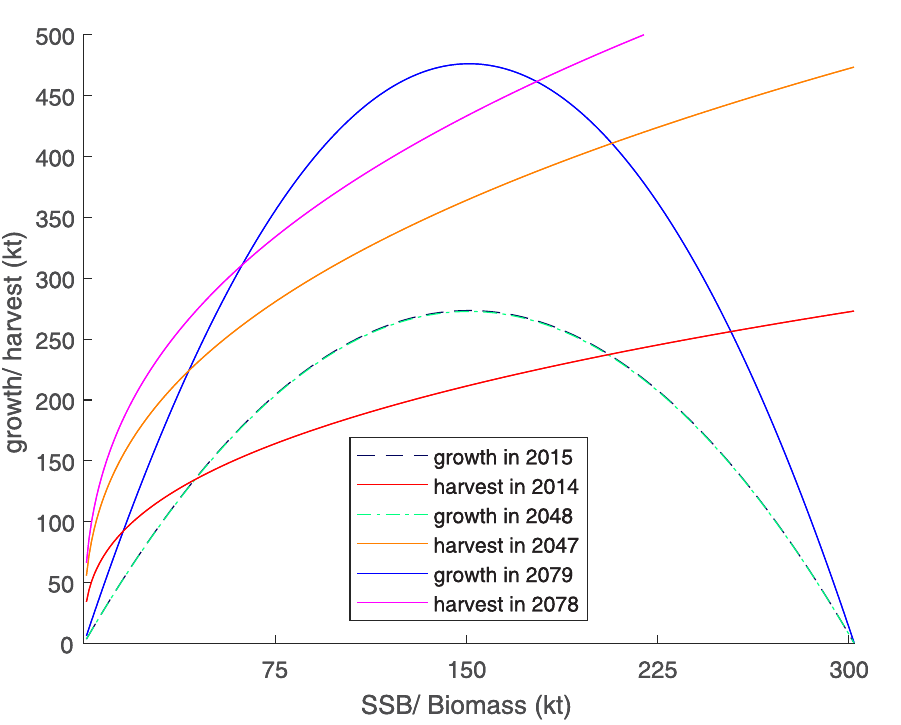
Fig 5. Annual harvest and biomass growth as a function of (spawning stock) biomass for exemplary years under ECE-o.